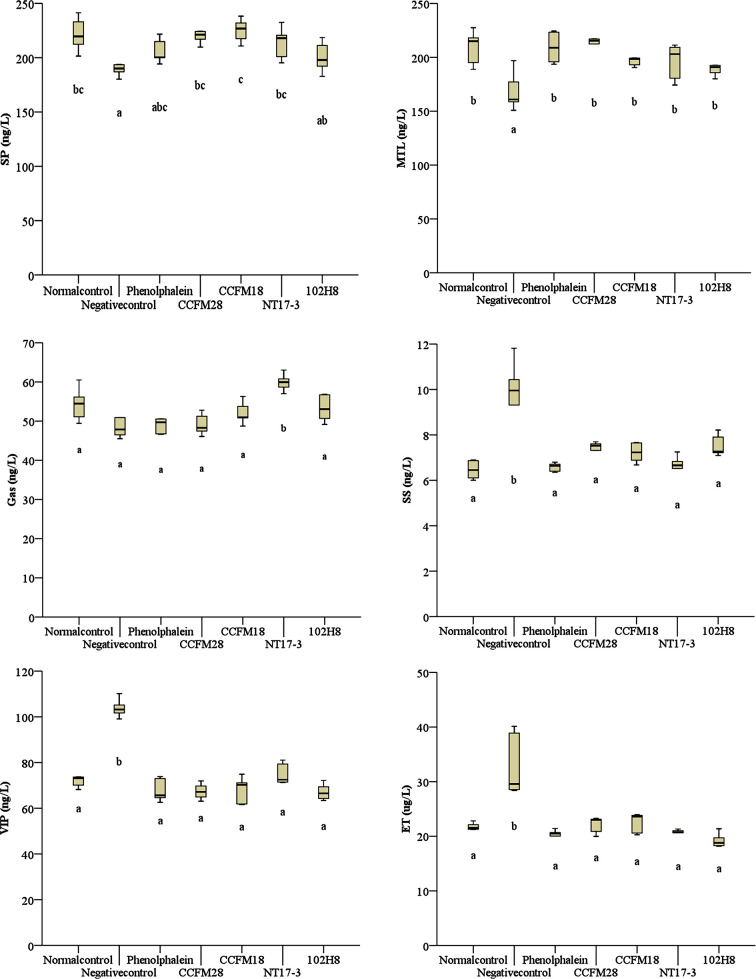
Levels of gastrointestinal regulatory peptides in the serum of BALB/c mice after constipation had been induced by loperamide hydrochloride and different treatments were given (n = 10). SP: substance P; MTL: motilin; Gas: gastrin; SS: somatostatin; VIP: vasoactive intestinal peptide; ET: endothelin. (A) Normal control: no treatment; (B) negative control group: physiological saline; (C) positive control group: phenolphthalein (70 mg/kg body weight); (D) treatment group: P. acidilactici CCFM28 strain; (E) treatment group: P. acidilactici CCFM18 strain; (F) treatment group: P. acidilactici NT17-3 strain; (G) treatment group: P. acidilactici 102H8 strain. The letters a, b, and c indicate significant differences (P < 0.05) as determined using Duncan’s multiple range test.